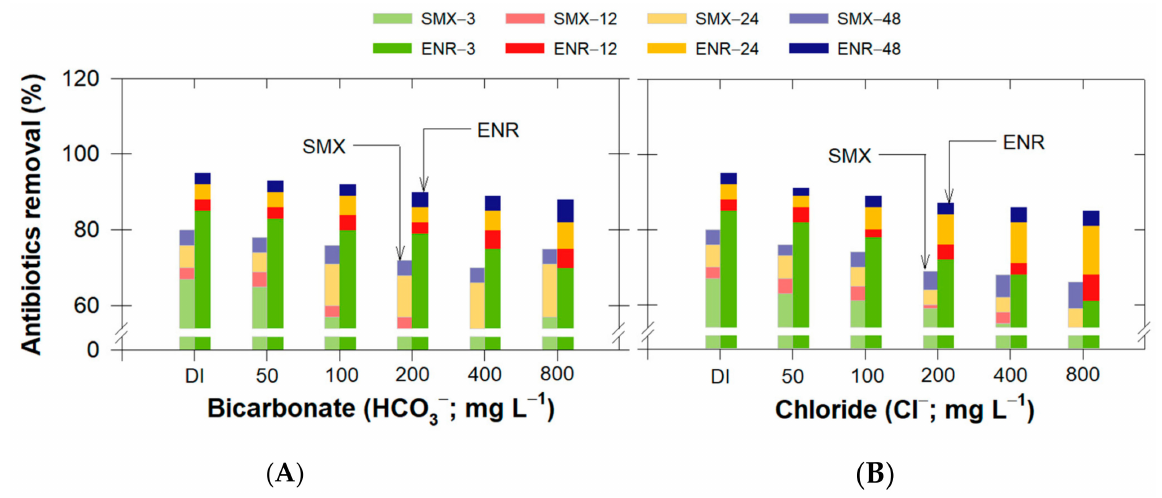
Figure 8. ( A ) Clear zone difference of Staphylococcus aureus ATCC 25923 after 24-h adsorption (C ∆ -24h ) of ENR onto each type of cLND (cLND450 and cLND550), and ( B , C ) clear zone examples at two ENR concentrations (20 and 40 mg L − 1 ) onto